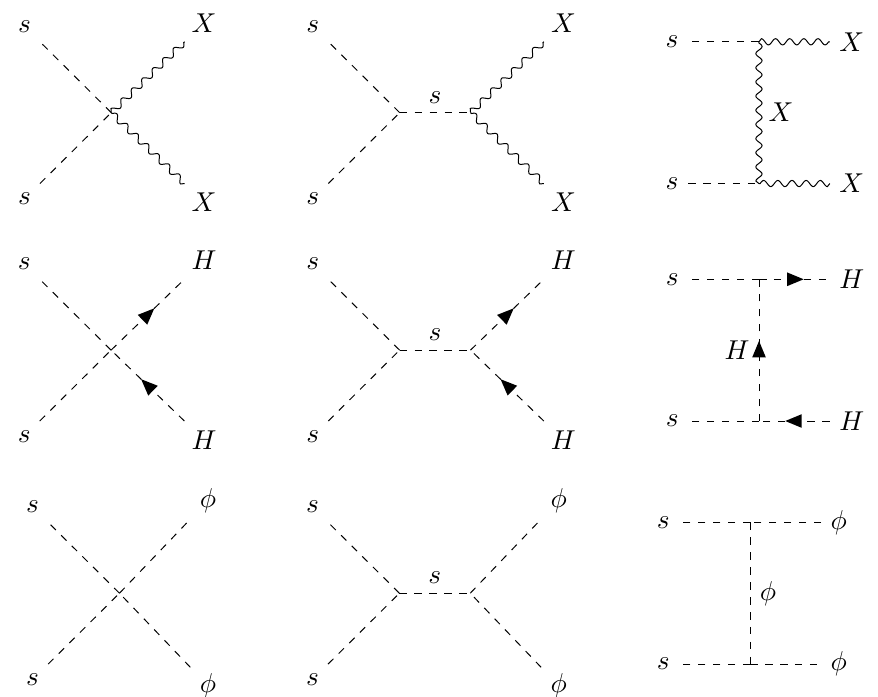
Figure 6 . Feynman diagrams showing all possible annihilation channels of s , which causes s to freeze out from thermal bath